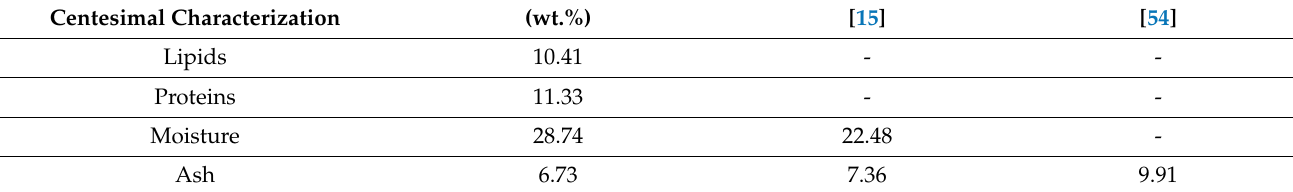
Table 3. Centesimal characterization for lipids, proteins, moisture, ash, pH, and electrical conductivity of dried, crushed, and sieved fraction of MHSW (organic matter +